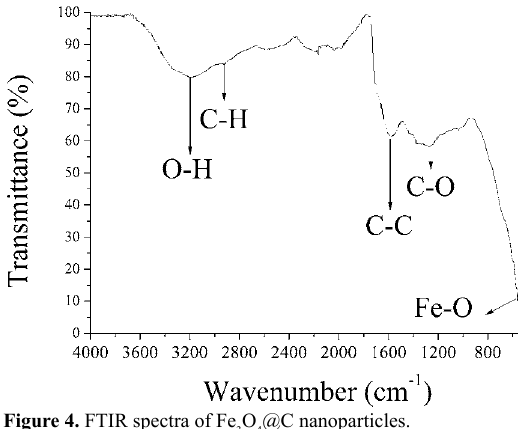
Figure 4. FTIR spectra of Fe